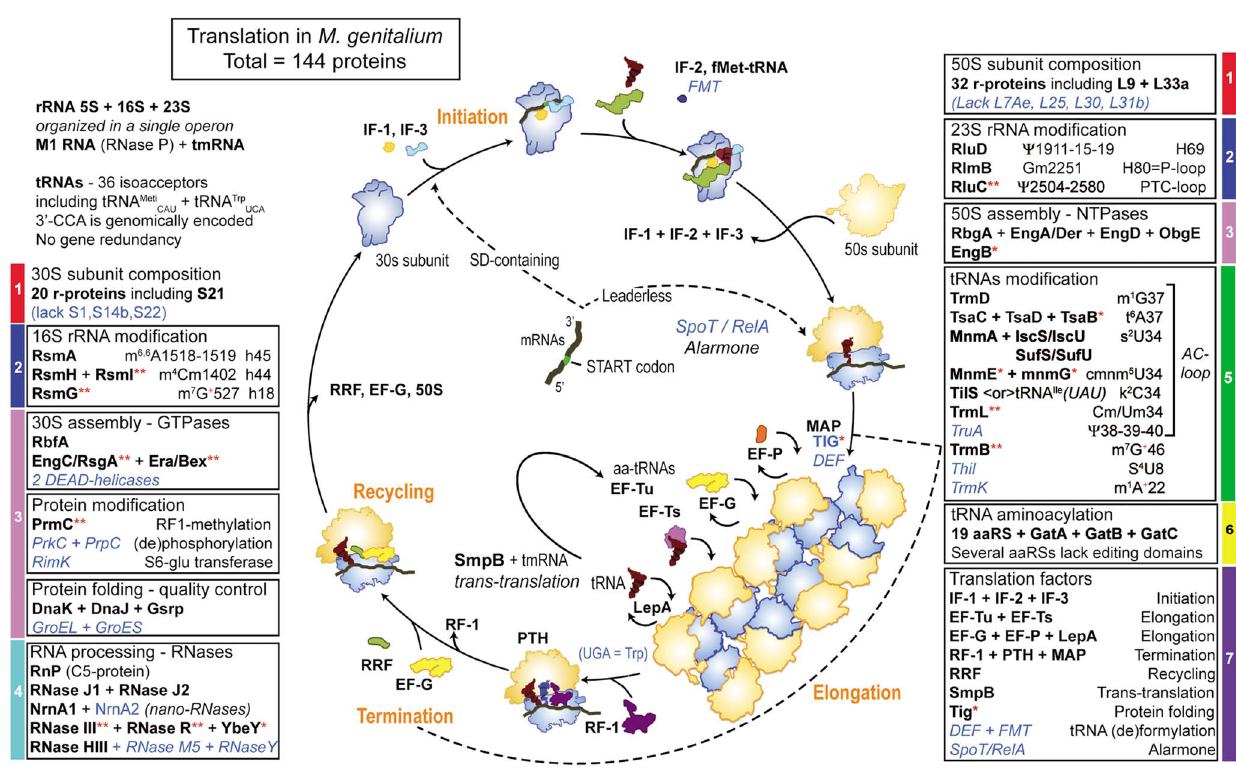
Figure 5. Schematic view of ribosome assembly and translation cycle in M.genitalium . In each box are indicated the acronyms of proteins encoded in the genome of M. genitalium (Table S3). The acronyms in black bold letters correspond to proteins listed in Figure 4 (A + B) of the minimal protein synthesis machinery (MPSM), only RlmB2 , or . YqxC is missing (see text). When the acronym is followed by a red asterisk, the protein is absent in the non-culturable M. suis and when followed by double asterisks, proteins are absent in the 3 hemoplasmas and/or the phytoplasmas. The acronyms in italic blue letters correspond to proteins that are absent in many mollicutes, but present in M. genitalium and M. pneumoniae . The color codes for each box are the same as in Table 1. Steps of translation are indicated in orange. Elongation (ribosomes assembled on mRNA forming polysomes) and termination are indicated by a circle dashed line. The step corresponding to the action of RF-1 has been isolated from the rest of the polysome, for better visualization. Depending on whether an mRNA harbors a 5 9 -leader sequence with SD-sequence or is leaderless, initiation occurs either on 30S subunit or 70S ribosome respectively. This figure allows a direct comparison with the similar one for translation cycle in Bacteria versus Eukaryotes published by Melnikov et al from M. Yusupov’s laboratory in Strasbourg, France